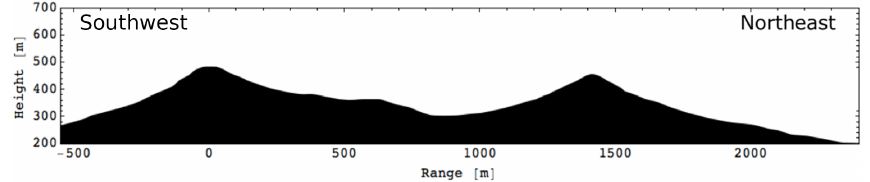
Figure 2. Wind turbine transect oriented 54 ◦ to the north. The wind turbine is located at 0m